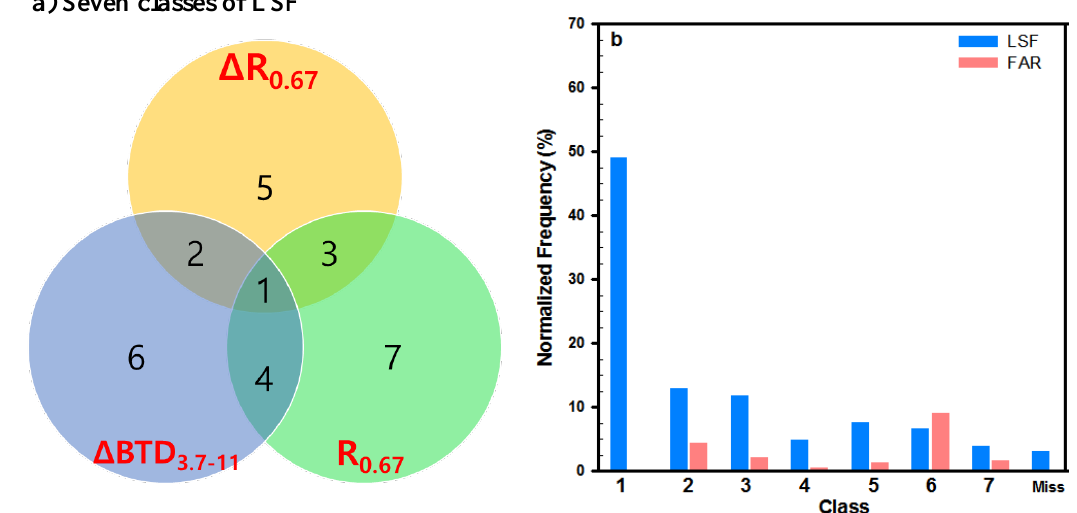
Figure 3. ( a ) Seven classes from the combination of the three threshold tests using ∆ R 0.67 , ∆ BTD 3.7-11 , and R 0.67 for the formulation of the LSF probability index (PI) in the dual-satellite method (DSM). ( b ) Normalized frequency distributions of the classes. Table 3. Normalized Frequency of LSF (NFL) and weighting factor (WF) values for each class of the DSM. The terms ‘NFL’ and ‘WF’ are defined in the text. ‘WF*’ has been obtained from the frequency ratio of fog cases to the whole data (i.e., fog and clear-sky) to include the false alarm rate (FAR) effect. Class Miss